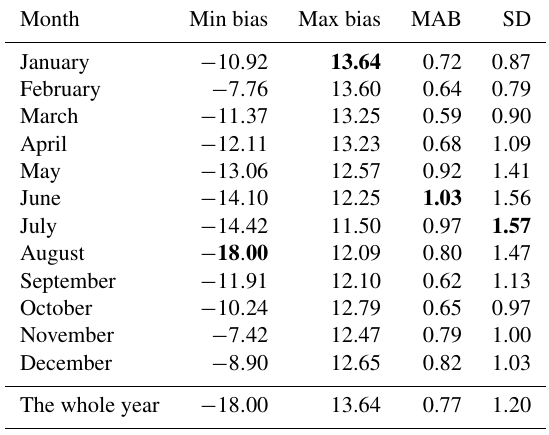
Table 3. Statistics of systematic biases in different months and the whole year (unit: